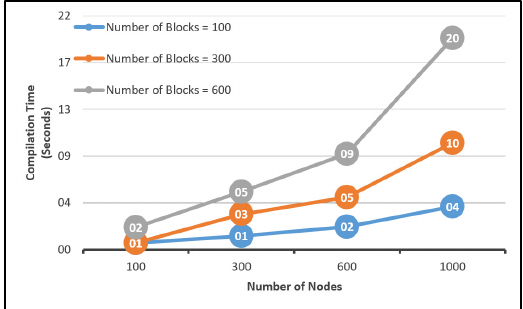
Figure 7. Time required to compile the original SimBlock simulator program.